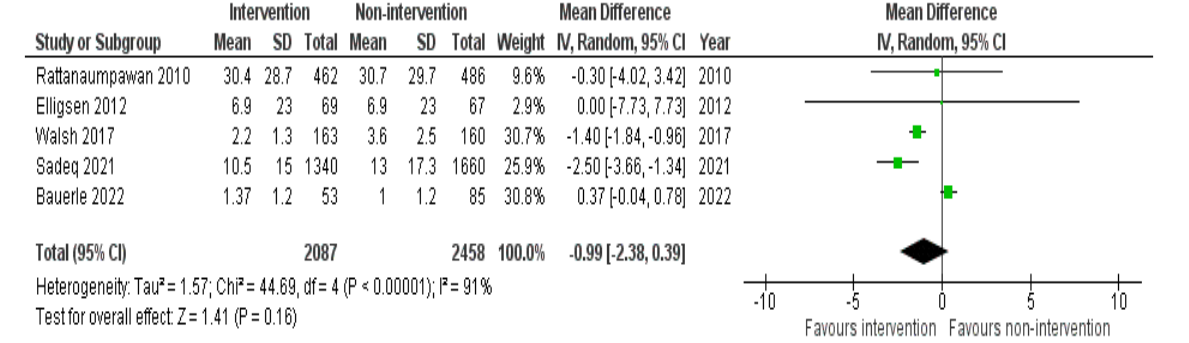
Figure 3. Pooled data from inpatient studies representing the impact of antimicrobial stewardship program intervention on length of hospital stay when comparing non-intervention with interven- tion groups. intervention